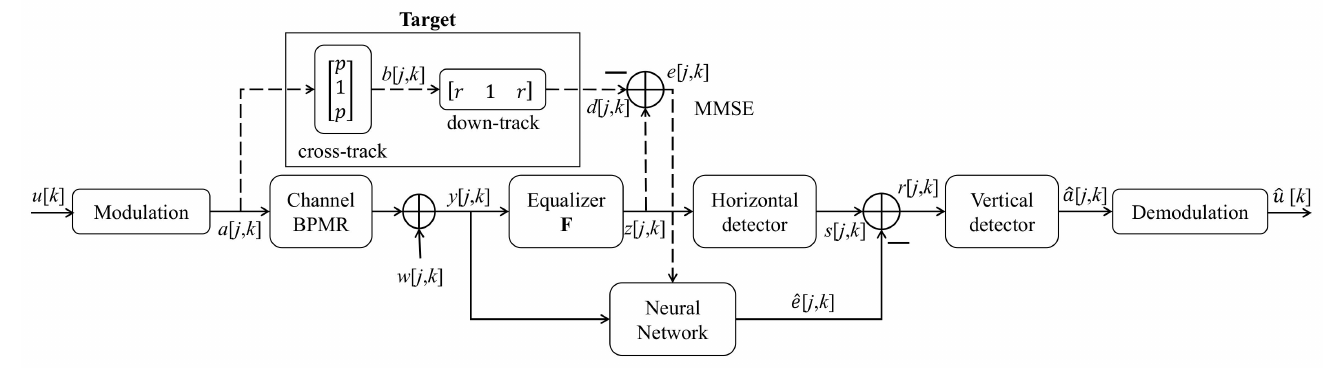
Figure 9. Our proposed system